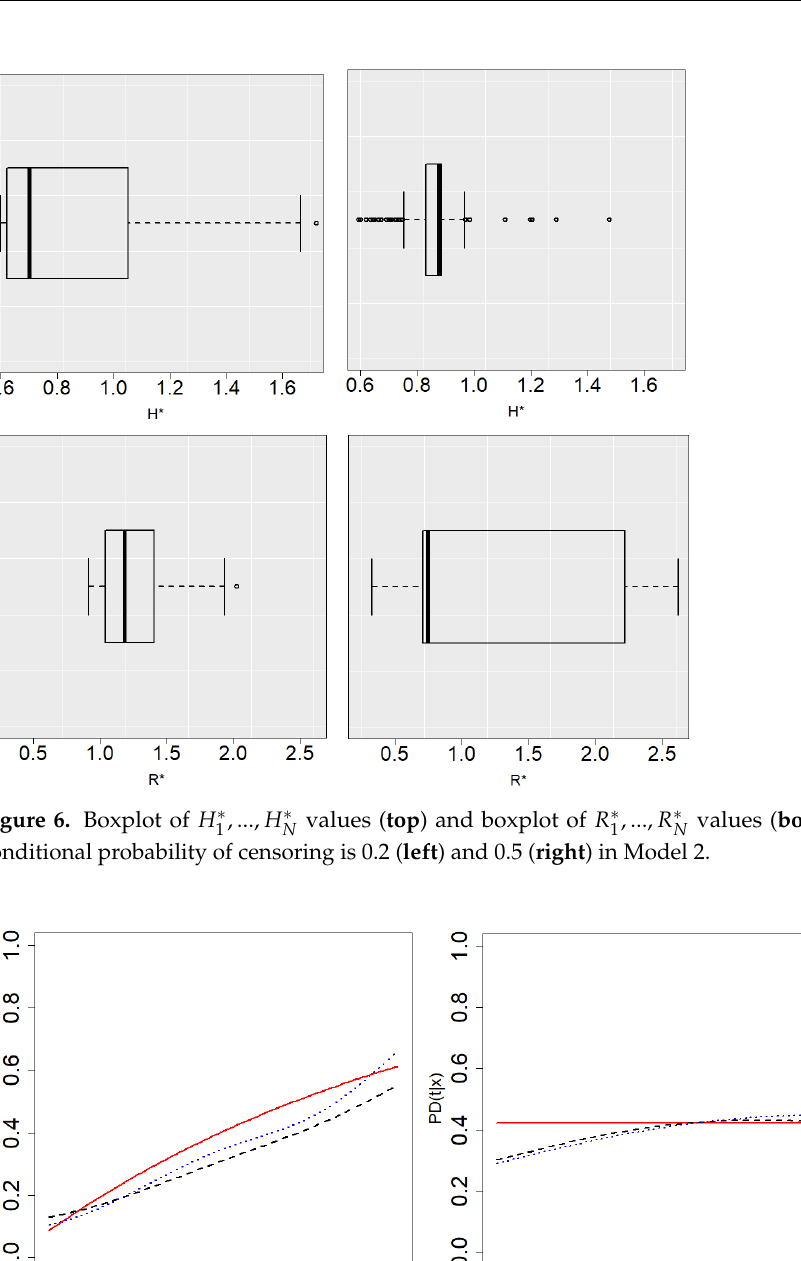
Figure 7. Theoretical probability of default function, PD ( t | x ) , (solid line), smoothed Beran’s estima- tion with MISE bandwidth (dotted line) and smoothed Beran’s estimation with bootstrap bandwidth (dashed line) for one sample from Model 1 ( left ), Model 2 ( right ) with P ( δ = 0 | x ) =